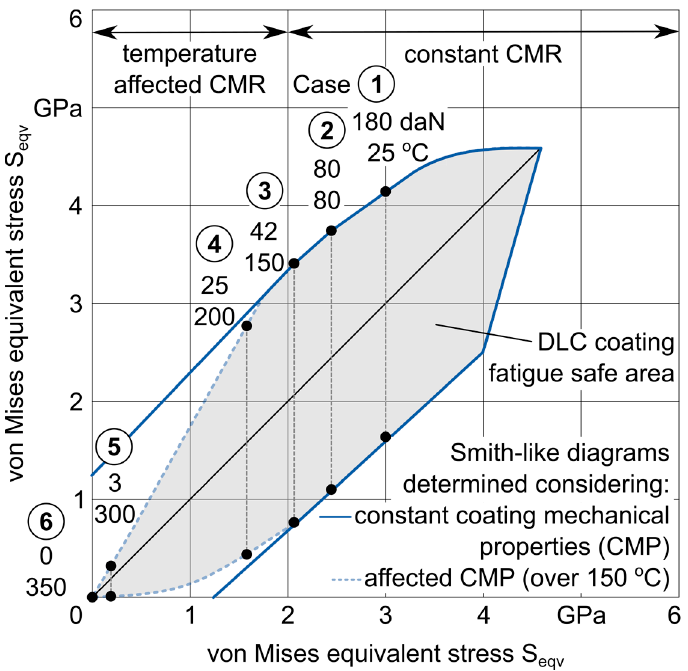
Figure 17. DLC coating Smith-like diagrams determined considering constant mechanical properties as well as temperature affected